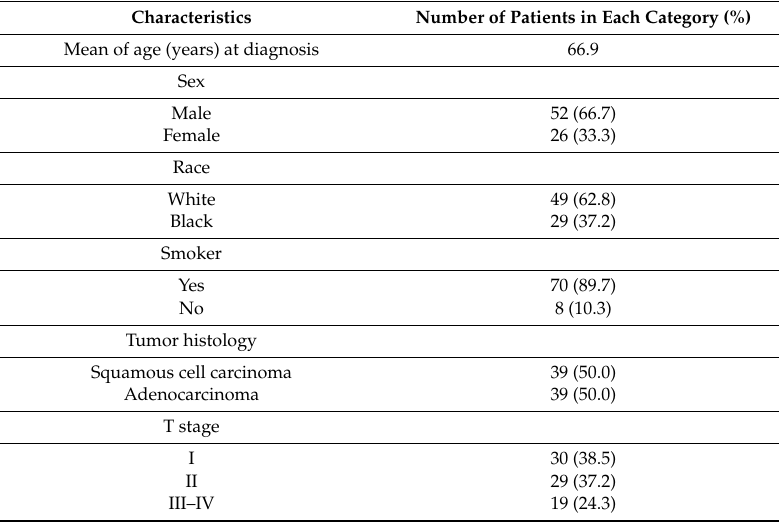
Table 2. Demographic and clinical characteristics of 78 NSCLC